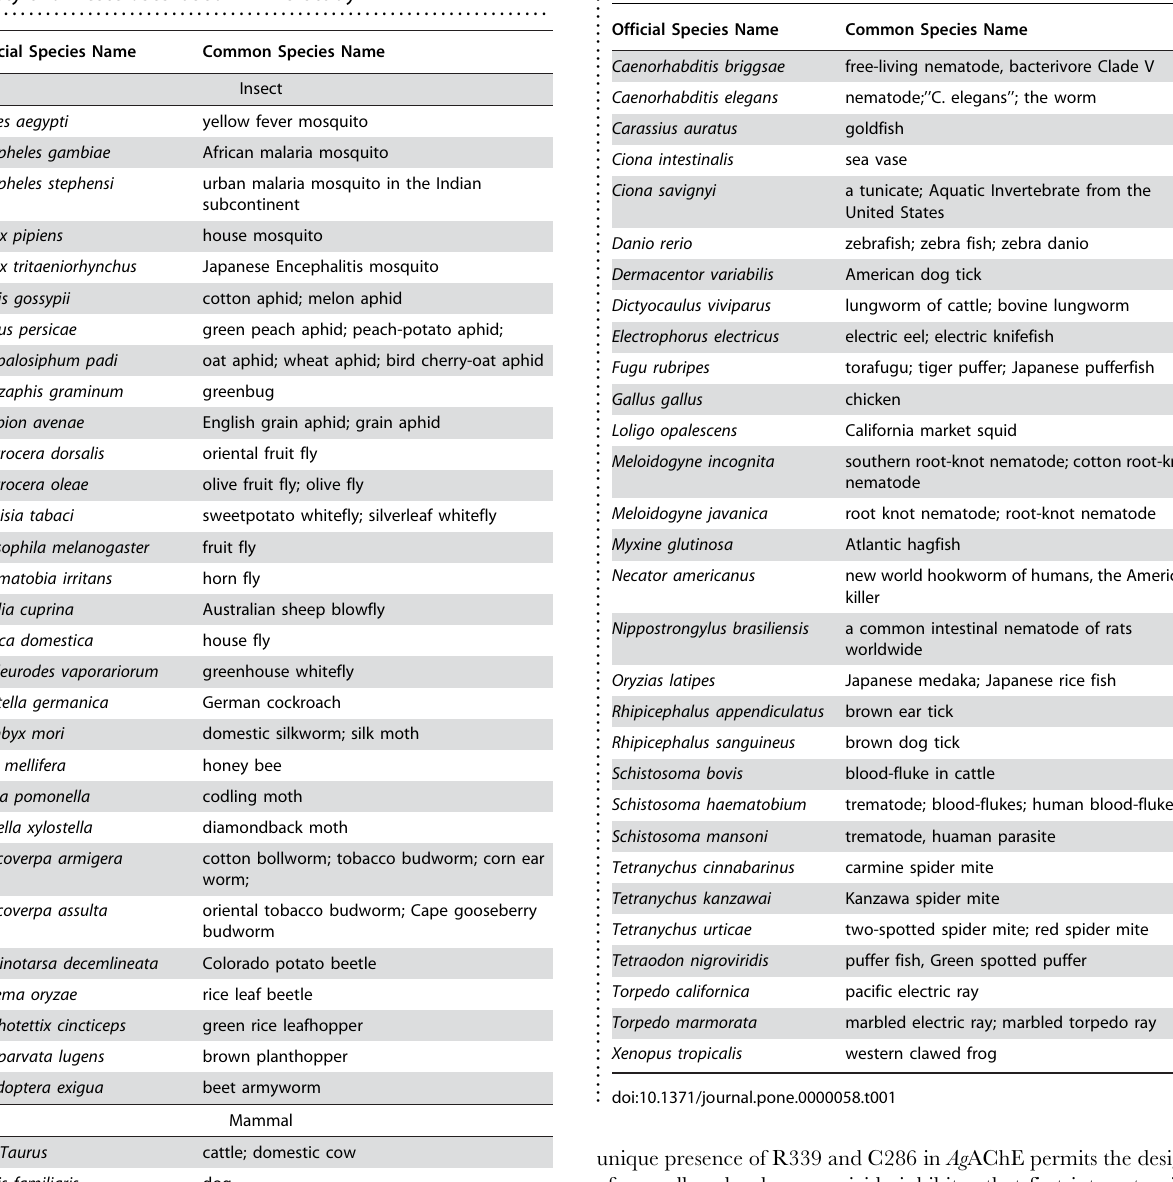
Table 1. Official and Common Species Names of the